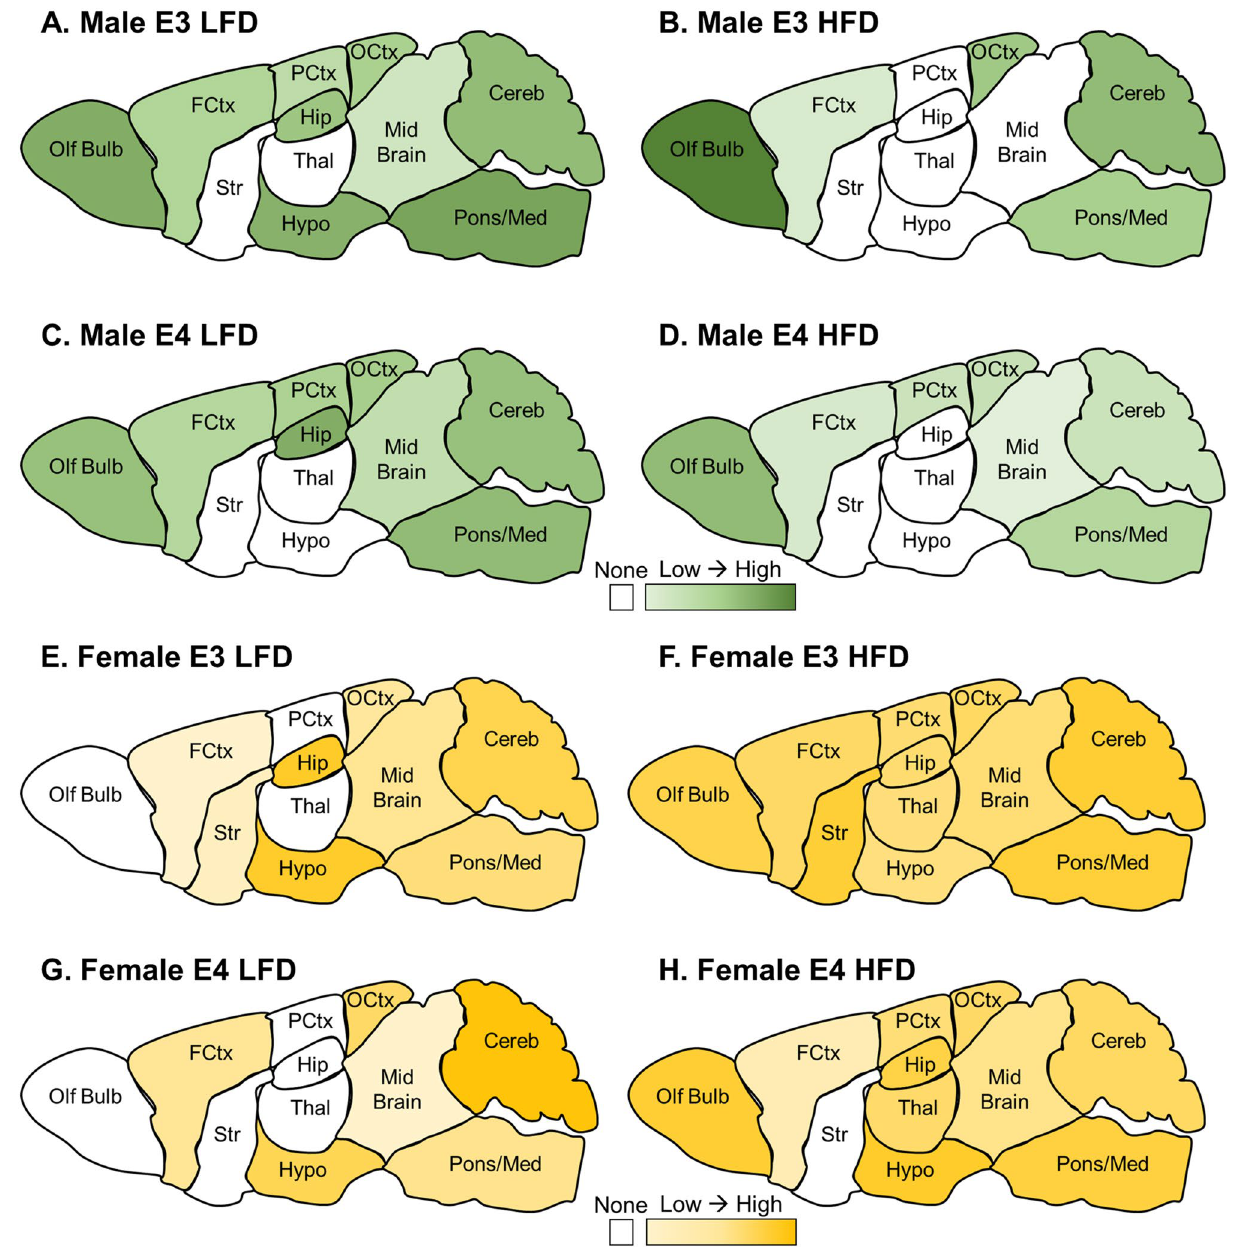
Figure 6. Regional Transport Rates Heat Map (µl/g-min). Heat maps were generated based on the data in Supplementary Table 2 and 3. ( A – D ) Males and ( E , F ) Females were analyzed separately. The K i for each group, within each sex, was color coded based on the rate. White indicates non-significant transport. In males, the olfactory bulb in E3 mice on a HFD had the highest rate of transport whereas in females, the cerebellum in E4 mice on a LFD had the highest rate of